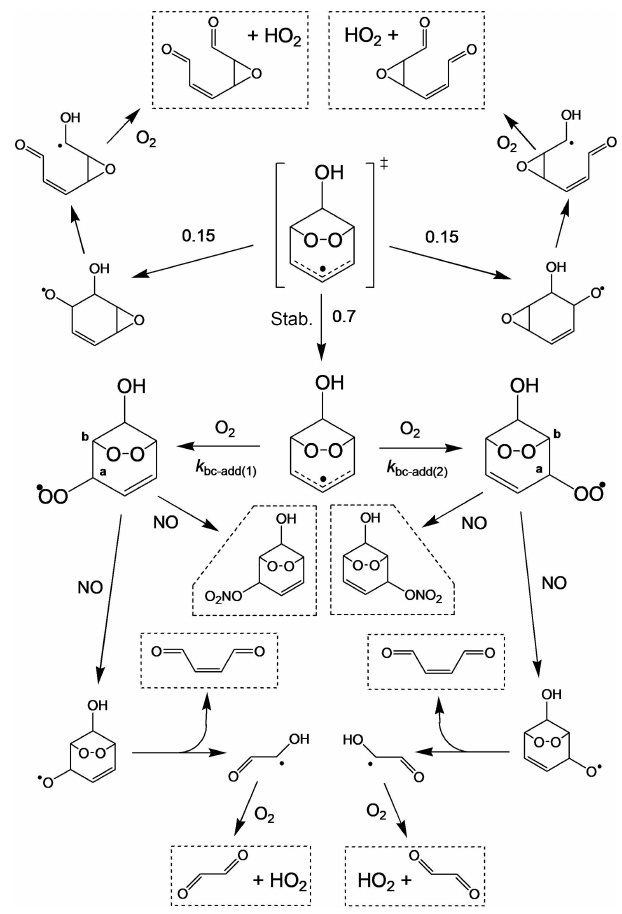
Figure 4. Schematic representation of the mechanism following formation of the “peroxide-bicyclic” radical, as shown in Fig. 3, with alkyl substituents omitted for clarity. The initial energy-rich “peroxide-bicyclic” radical is represented to isomerize as shown with a total optimized probability of 30% in competition with stabi- lization (see Sect. 4.1). Addition of O 2 to the stabilized radical can occur at two positions. The rate coefficients for the two addition pathways ( k bc-add ( 1 ) and k bc-add ( 2 ) ) depend on the number and dis- tribution of alkyl substituents at positions “a” and “b” in each case (see Sect. 4.1 and Table 9). The resultant peroxy radicals undergo conventional bimolecular reactions, with only those involving NO shown here. The oxy radicals formed from propagating channels de- compose to form α -dicarbonyls and (at least partially) unsaturated 1,4-dicarbonyl products, in conjunction with HO 2 , via the generally accepted mechanism shown.